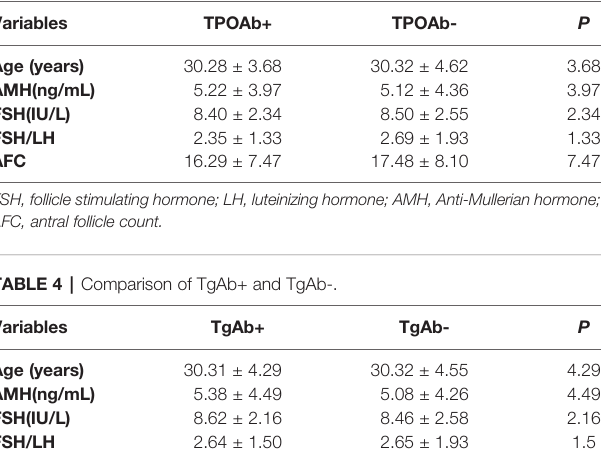
TABLE 3 | Comparison of TPOAb+ and TPOAb-.